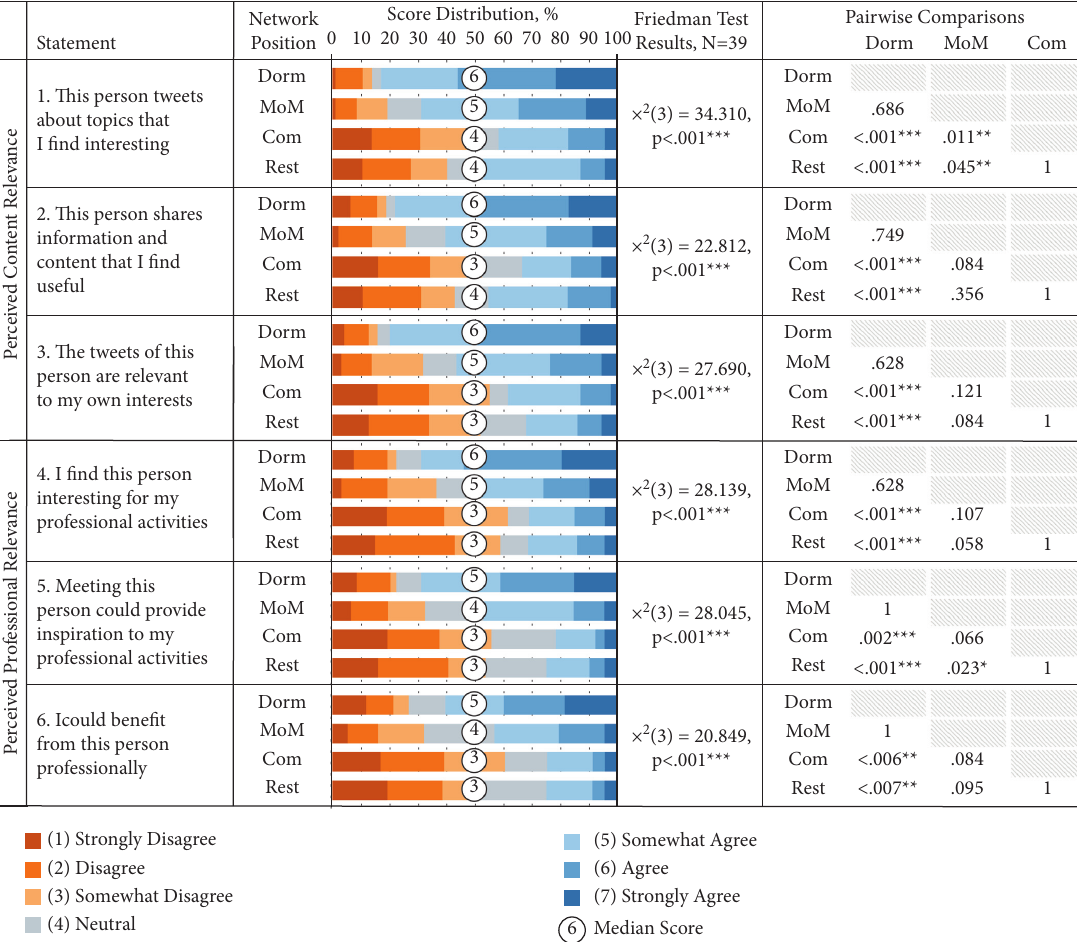
Figure 7: Proportions of given scores regarding perceived content and professional relevance of recommendations from each structural network position, and the results of Friedman test with details on Bonferroni corrected pairwise comparison. 72 recommendations